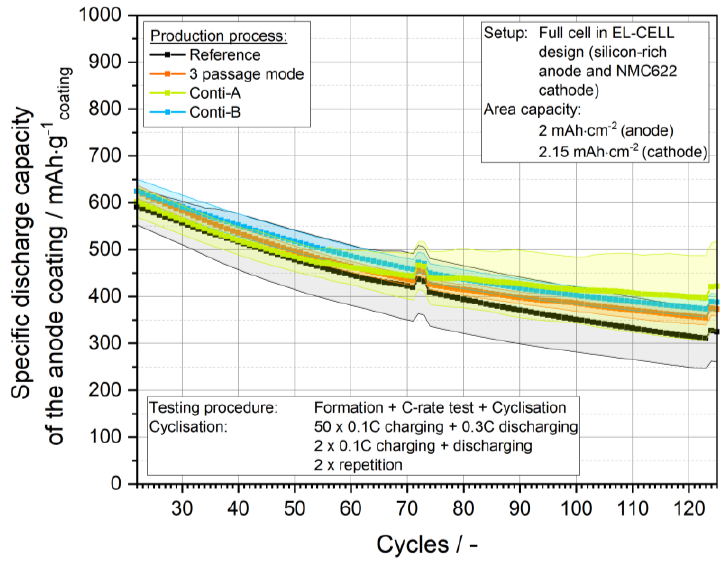
Figure 17. Specific discharge capacities of the silicon-rich anodes, which were produced by four different processes, as a function of the number of cycles during cycling (following the C-rate test, see Figure 16).